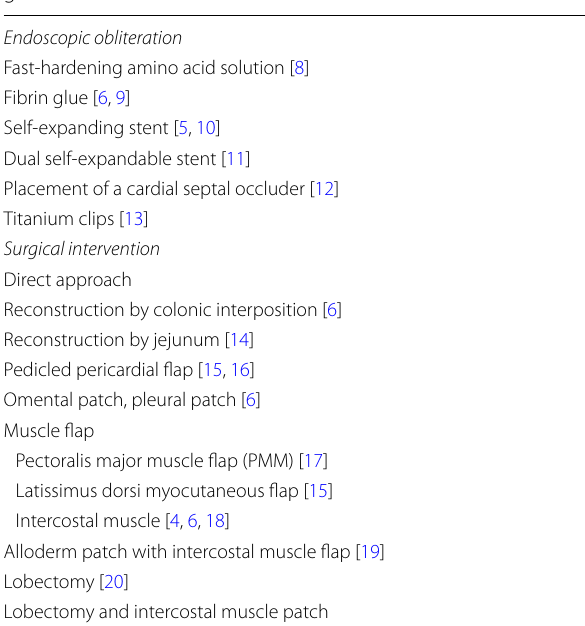
Table 1 Previously reported treatment